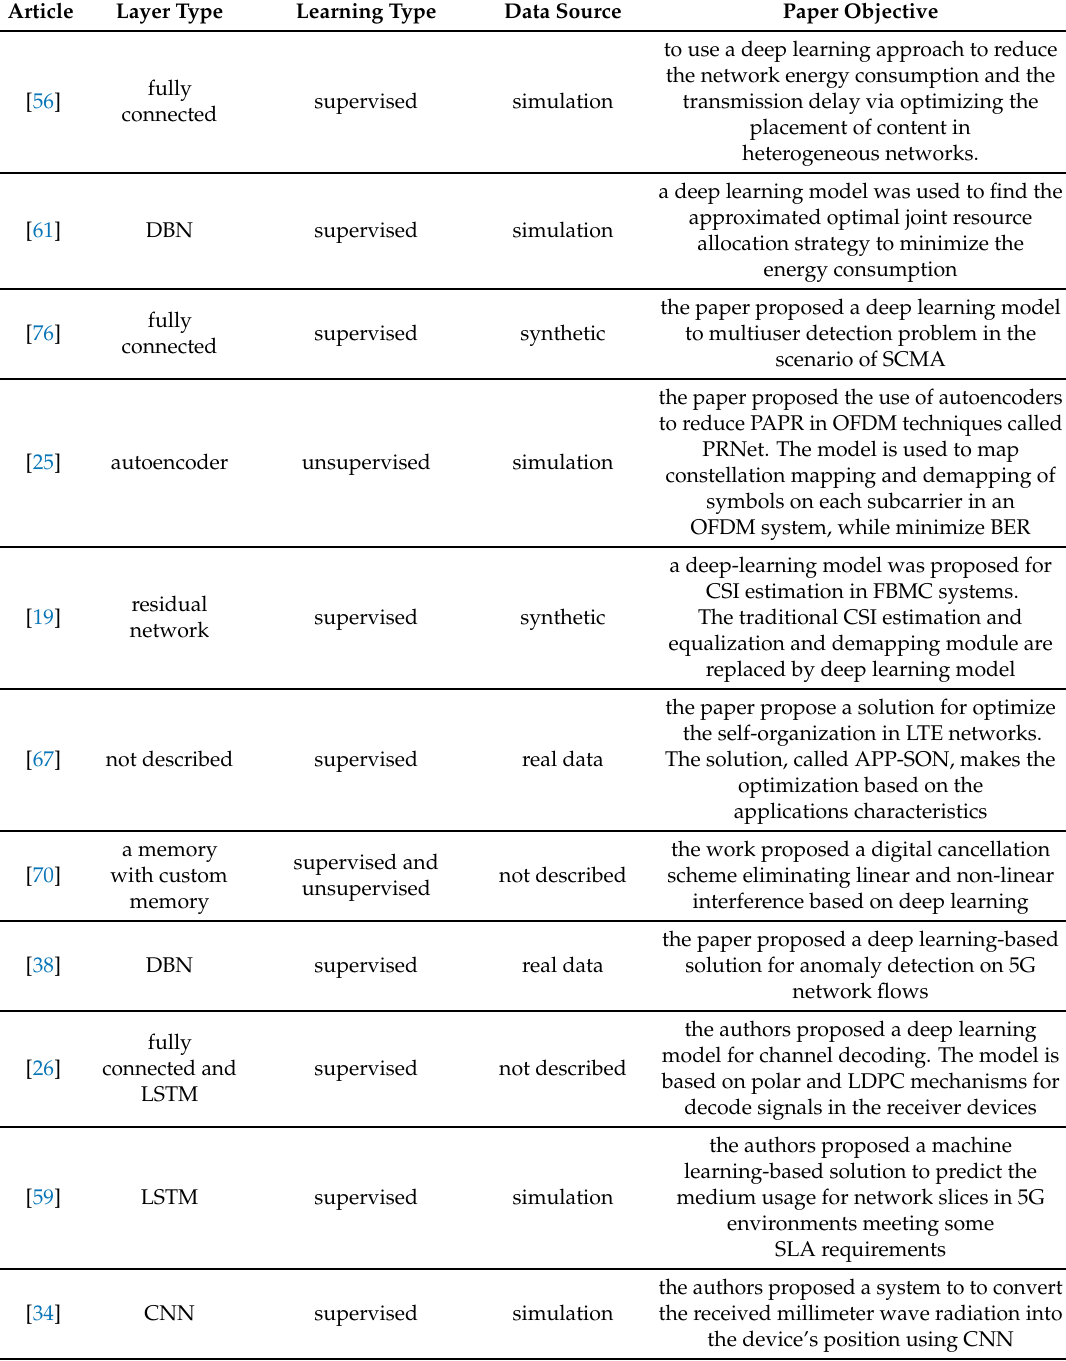
Table A1. Summary of works found in this systematic